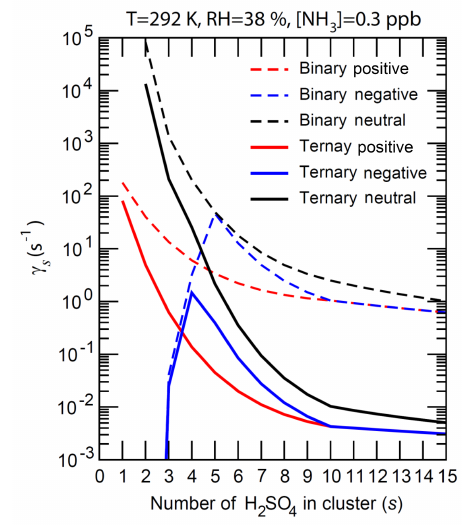
Figure 5. The number-concentration-weighted mean evaporation rates ( γ ) of H 2 SO 4 molecules from neutral clusters (black), positively charged clusters (red), and negatively charged clus- ters (blue) for binary (H 2 SO 4 –H 2 O, dashed lines) and ternary (H 2 SO 4 –H 2 O–NH 3 , solid lines) nucleating systems containing s H 2 SO 4 molecules ( (cid:49)G s − 1 ,s ). T = 292K, RH = 38%, and [NH 3 ] = 0.3ppb for the ternary